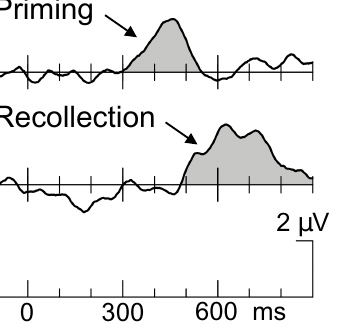
Fig.5. Brain potentials specifically associated with visual word-form priming and recollection. The upper waveform was computed by subtracting brain potentials elicited by words previously viewed for- ward or backward; priming magnitude was relatively greater in the studied-forward condition [87]. The lower waveform was computed by subtracting brain potentials elicited by words previously studied in an imagery task versus an orthographic task; recollection was rela- tively stronger in the imagery condition [88]. Recordings were made from the midline parietal scalp location and positive potentials are shown as upward